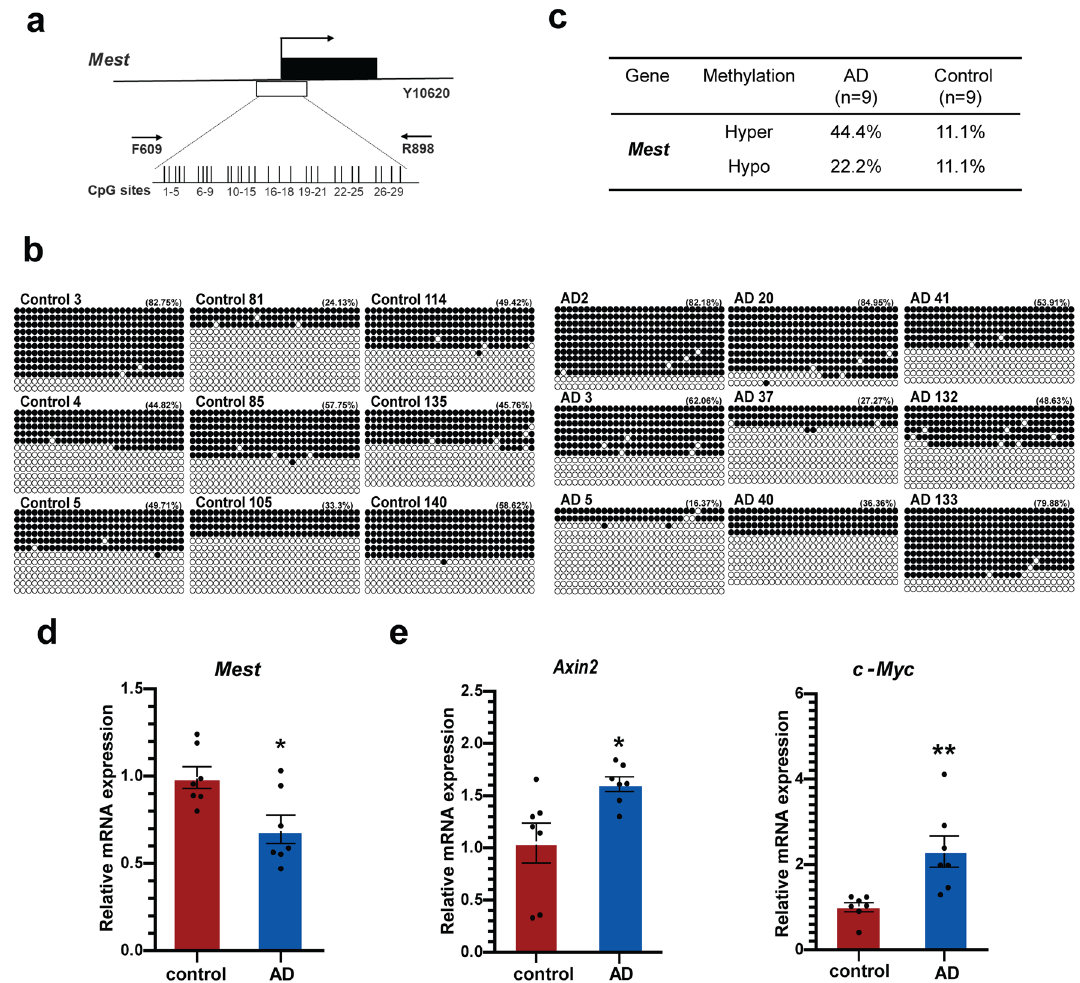
Figure 1. Hypermethylation of Mest promoter and upregulation of Wnt signaling in brain samples from AD patients. ( a ) Schematic diagram of differentially methylated regions (DMRs) of Mest gene promoter (GenBank accession no. Y10620, nucleotides 609–898) is represented as a horizontal line. The transcriptional start site is indicated by an arrow. The vertical bars represent CpG sites. Horizontal arrows (F609 & R898) represent the primers used to amplify the DMRs. ( b ) Comparison of CpG methylation patterns within the Mest promoter in DNA isolated from the cortex of age-matched controls (n = 9) and AD subjects (n = 9) show elevated hypermethylation alleles in AD subjects. ( c ) Summary of Mest promoter methylation in age-matched controls (n = 9) and AD (n = 9) subjects. ( d ) The Mest mRNA levels are decreased in AD patients. Mest mRNA expression is downregulated in the temporal cortex of sporadic AD postmortem brains (n = 7) in comparison to age-matched controls (n = 7). GAPDH was used to normalize Mest expression. *Significantly different from the control at p < 0.01. ( e ) mRNA levels of the Wnt target genes Axin2 and c-Myc were increased in AD subjects (n = 7). mRNA levels were normalized to that of β-actin. Data are shown as mean ± SD; *, p < 0.05; **, p < 0.01; ***, p < 0.001 compared with the corresponding control group. Student’s t test was used for statistical